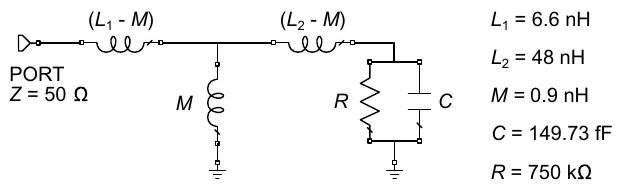
FIG. 7. Simplified circuit model. The inductively coupled spi- ral inductor and microstrip waveguide can be approximated as a T circuit. All of the parasitic capacitances in the system are com- bined with the gate capacitance into the one capacitor shown. The total losses are accounted for by the 750-k (cid:4) resistor.